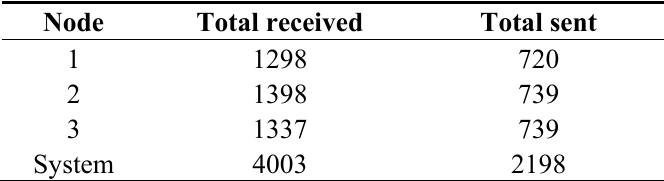
Table 7. Messages sent and received in dynamic test.